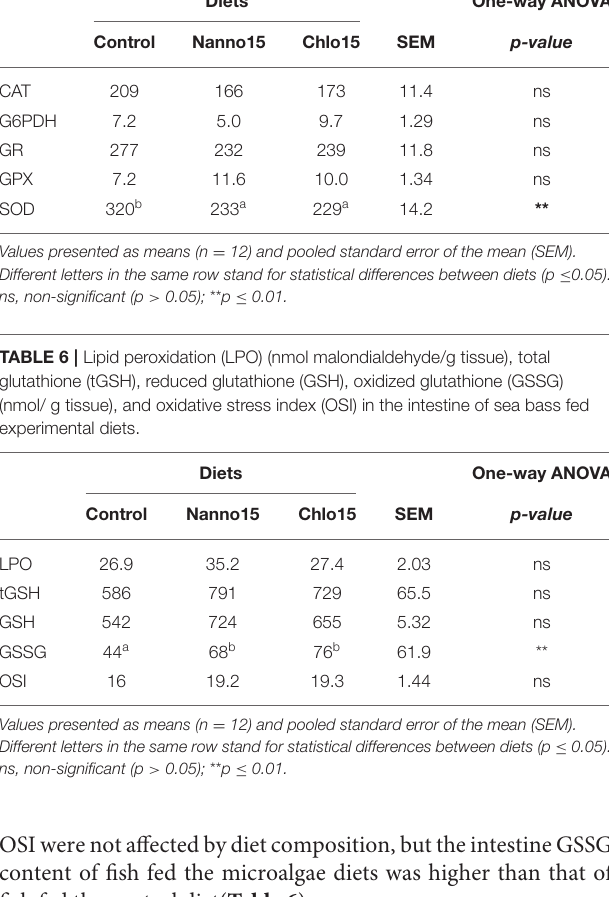
TABLE 5 | Specific activities of glucose-6-phosphate dehydrogenase (G6PDH), glutathione peroxidase (GPX), glutathione reductase (GR) (mU/mg protein), catalase (CAT), and superoxide dismutase (SOD) (U/mg protein) in the intestine of sea bass fed the experimental diets. Diets One-way ANOVA